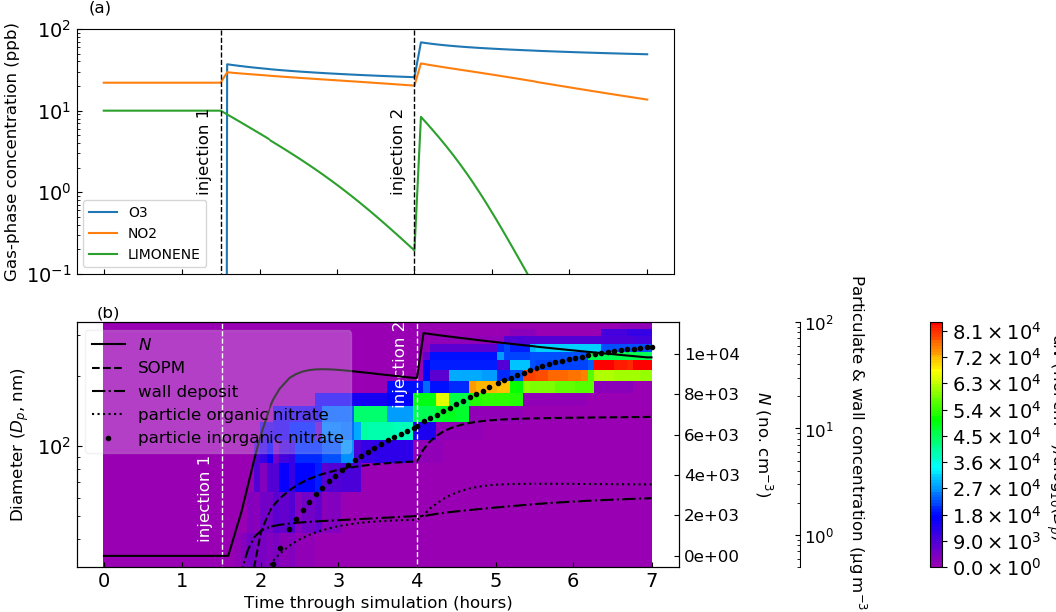
Figure 1. Limonene oxidation in the dark with and without seed particles. In (a) are the gas-phase concentrations of key components, and in (b) are the particle properties. At the start 10ppb of limonene, 22ppb of NO 2 and 500ppm of CO are introduced. At 1.5h 38ppb of O 3 and 8ppb of NO 2 are injected (injection 1). At 4h a further injection of O 3 (45ppb), limonene (10ppb) and NO 2 (19ppb) is coincident with an injection of seed aerosol (10µgm − 3 with a mean diameter of 0.2µm) (injection 2). In (b) , the total particle number concentration ( N ) corresponds to the first of the right axes. The second of the right axes corresponds to the following: the mass concentration of secondary organic particulate matter (SOPM), components deposited to walls (wall deposit), the sum of particulate organic components with a nitrate functional group (particle organic nitrate) and the sum of particulate inorganic components with a nitrate functional group (particle inorganic nitrate). Number size concentrations correspond to the filled contours, colour bar and left axis. Whilst N includes seed particles, SOPM excludes the seed material, and all mass concentrations exclude